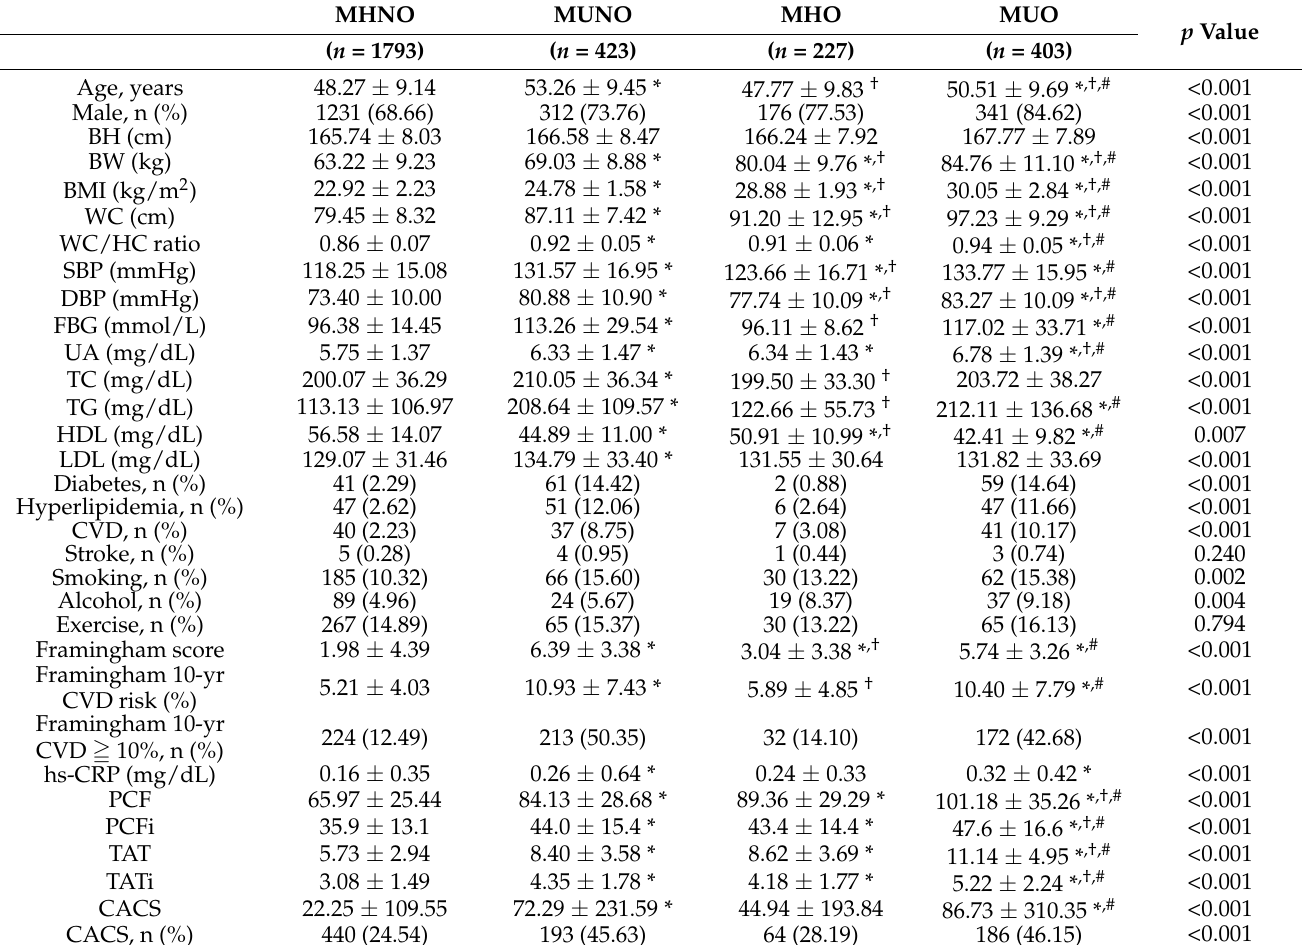
Table 1. Baseline characteristics of the study population.